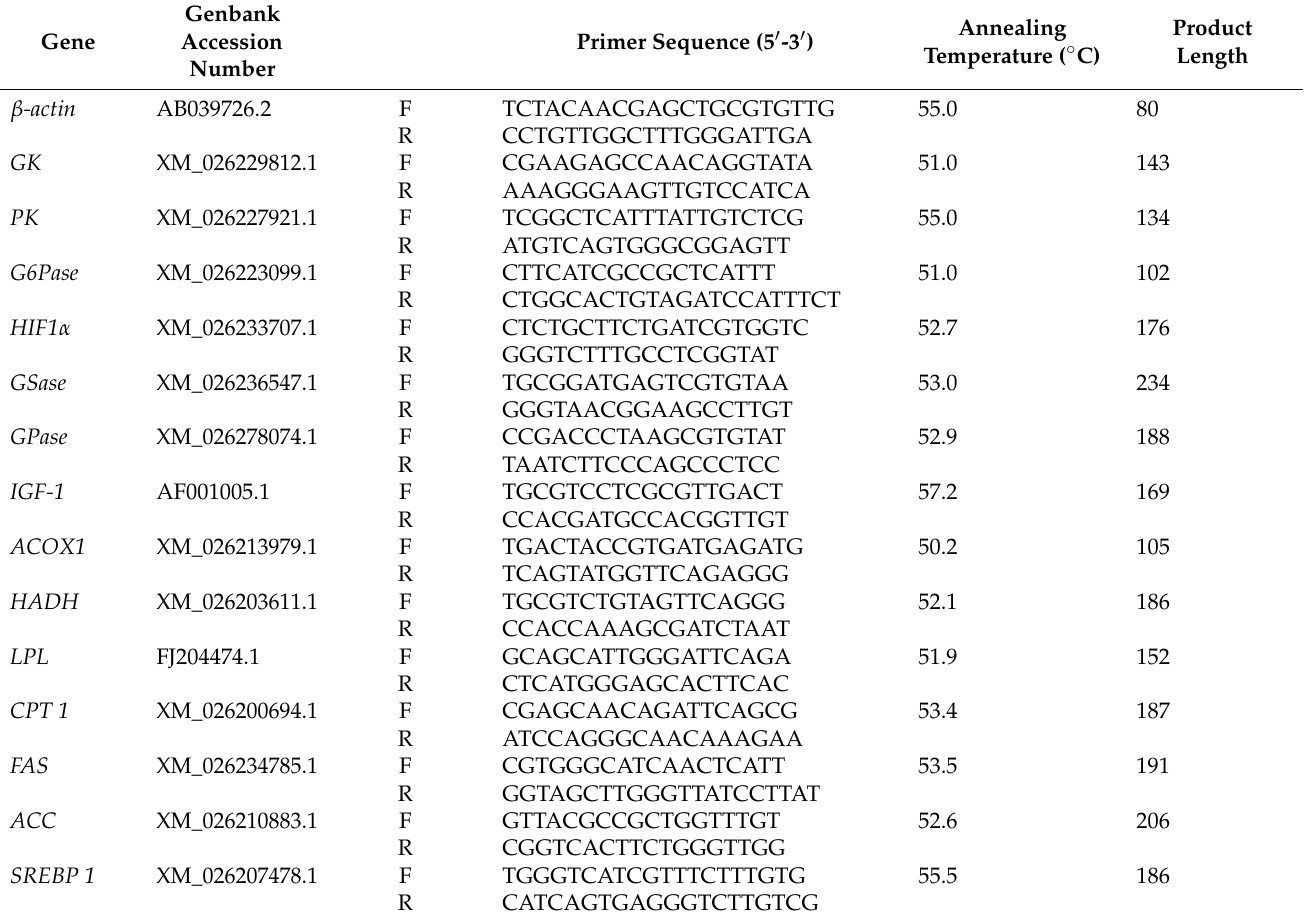
Table 5. Real-time PCR primer sequences.